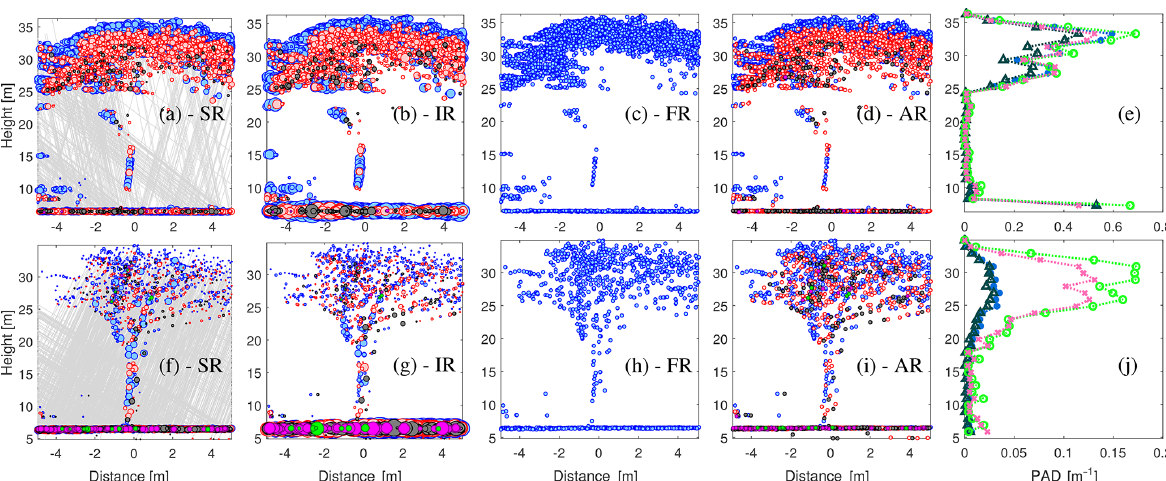
Figure 5. Backscatter reflections from within a 10m × 10m grid box taken from the Falster summer (a–e) and winter (f–j) scans. The color indicates the return number: first returns are represented using blue, second returns are represented using red, third returns are represented using black, fourth returns are represented using purple, and fifth returns are represented using green. The size of the marker indicates the weight of the return according to the four methods. The scaled return number for SR (a, f) is determined from Eq. (7); for IR (b, g) , it is scaled by the medium intensity of the first-order canopy returns in the grid box; and for FR and AR (c, d, h, i) , all returns are weighted the same. Note that the scale changes between the summer and winter. The gray lines indicate the path of the lidar beam between first- and higher-order returns; thus, lines are only shown for beams that have more than one return. Panels (e) and (j) shows the corresponding PAD for the summer and winter scan, respectively. SR is represented using blue stars, IR is represented using dark green triangles, FR is represented using bright green circles, and AR is represented using pink crosses. The location of the grid cell can be seen in Figs. 3 and 4.